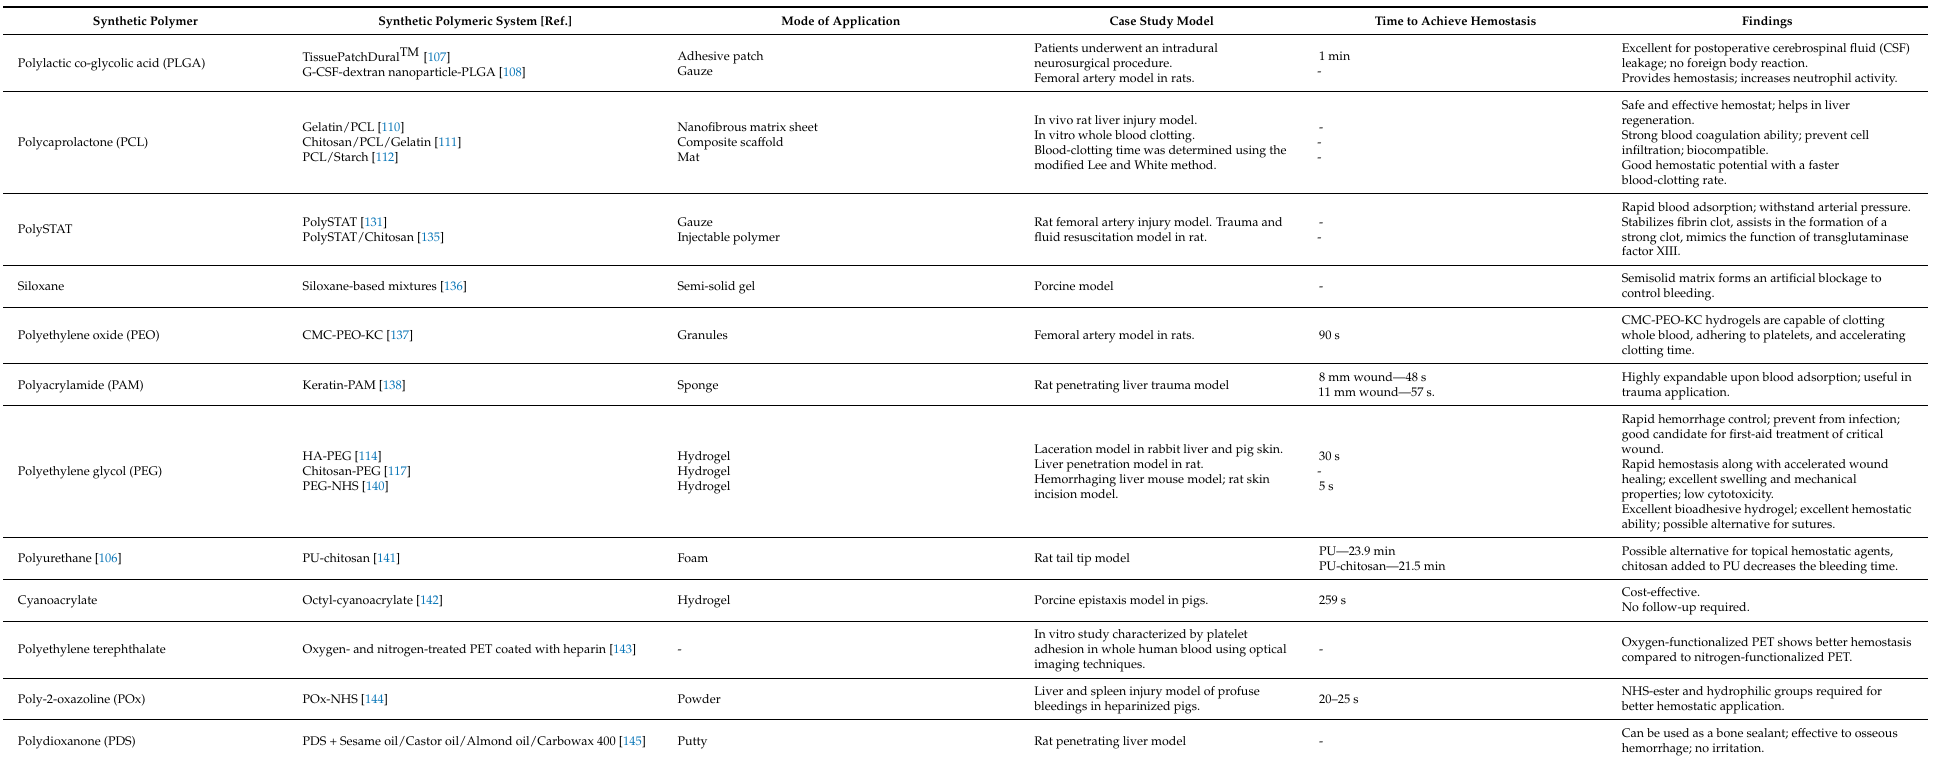
Table 2. Hemostatic functions of synthetic polymeric